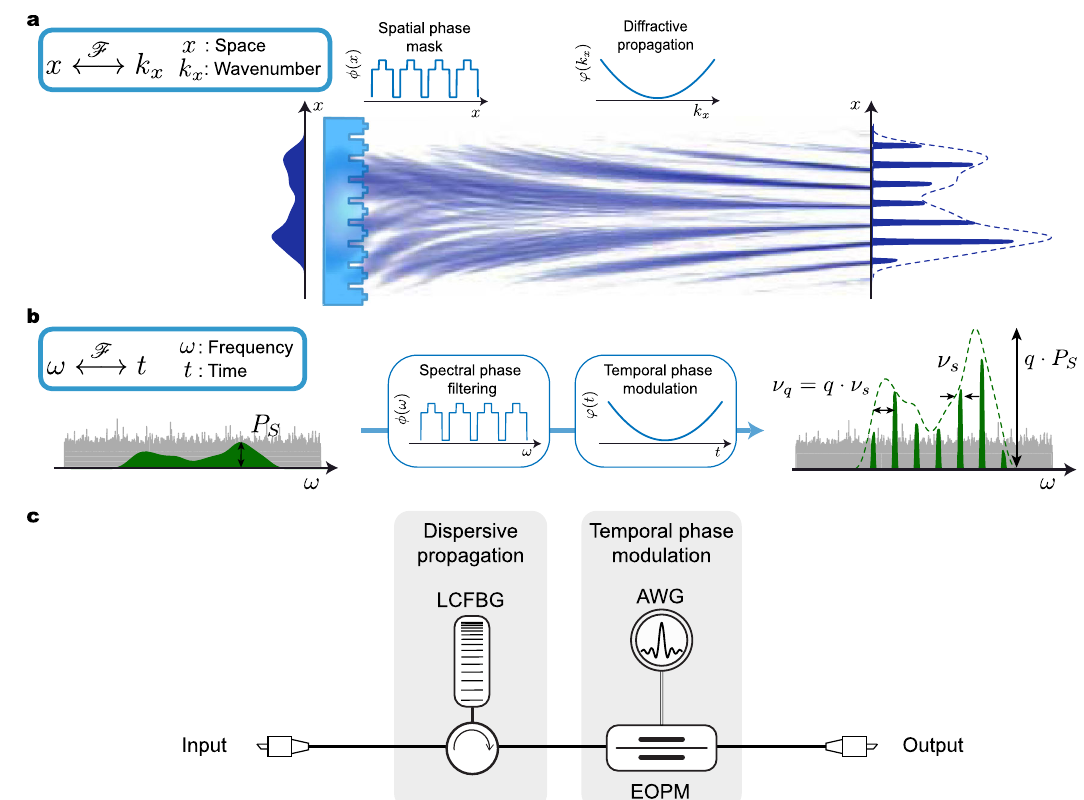
Fig. 1 S-TAI denoising concept. a Originally observed in the spatial domain, a Talbot Array Illuminator (TAI) focuses a uniform beam into an array of bright spots 21 . A TAI consists of a discrete phase mask ϕ (x) applied along the transversal spatial direction x , followed by free-space diffraction, which imposes a continuous quadratic phase φ (k x ) along the angular frequency variable k x , the Fourier-conjugate of x 26 . The involved Fourier transformation is indicated by the symbol ℱ . We show here that the well-known TAI mechanism can be applied on a non-uniform spatial wavefront. b Through a mathematical analogy between the space and temporal frequency domains, a similar process is implemented along the frequency spectrum representation of a temporal waveform (i.e., S-TAI). In this case, the observation domain is along the radial frequency variable ω , and its Fourier-dual domain is along the time variable, t . Thus, the S-TAI can be constructed by a suitable discrete spectral phase fi lter ϕ ( ω ) , followed by a continuous quadratic temporal phase modulation φ (t) , as detailed in the main text. This creates a sampled version of the input spectrum, with peaks of width ν s separated by ν q = q ν s , outlining a copy of the waveform of interest ampli fi ed by a factor q . On the other hand, the incoherent noise content (here illustrated as a gray background) is left untouched, thus enabling the recovery of a waveform initially buried under noise. c Experimental realization of the concept for optical waveforms, with the acronyms de fi ned in the text. For convenience, the S-TAI mechanism can be implemented through a continuous quadratic spectral phase transformation (dispersive phase fi ltering), followed by a periodic discrete temporal phase modulation process (see “ Methods ”